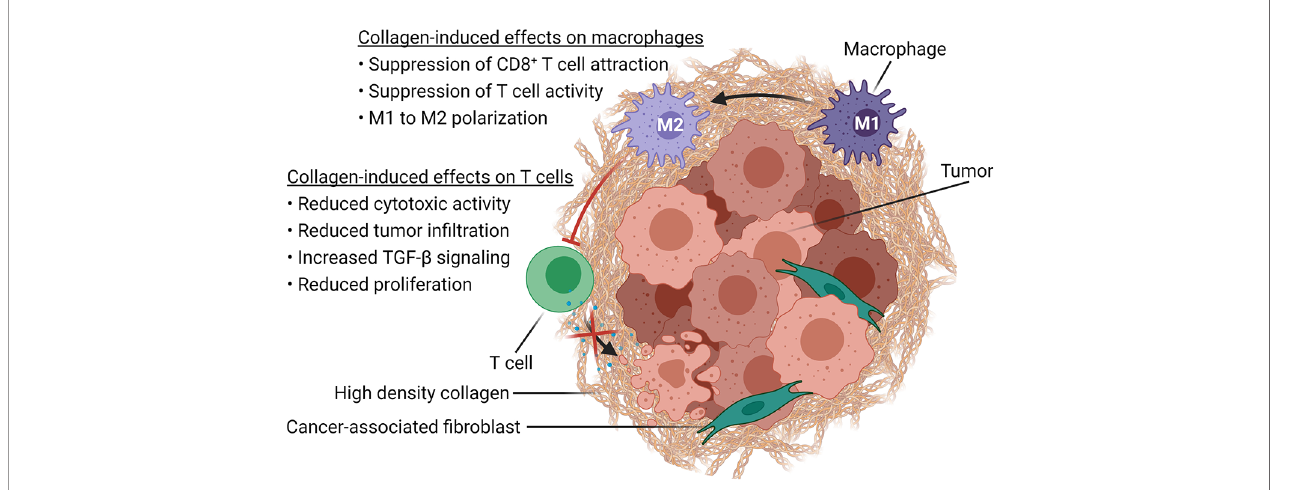
FIGURE 2 | Immune modulatory effects of high-density collagen in cancer. Schematic representation of how increased collagen density, associated with tumor progression, affects immune cells in the TME. High-density collagen drives M1 to M2 polarization of macrophages, which in turn suppresses CD8 + T cell attraction as well as T cell activity. High-density collagen also affects T cells directly by increasing TGF- b signaling and by reducing tumor in fi ltration, proliferation and cytotoxic activity. Created with